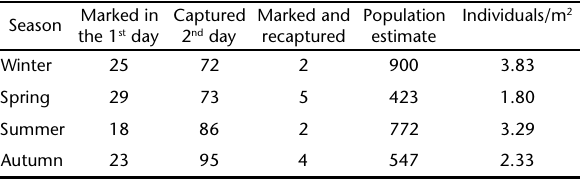
Table IV. Petersen’s estimate of population size of Aegla platensis in the Lajeado Bonito stream, Uruguay Basin, Rio Grande do Sul state, Brazil.